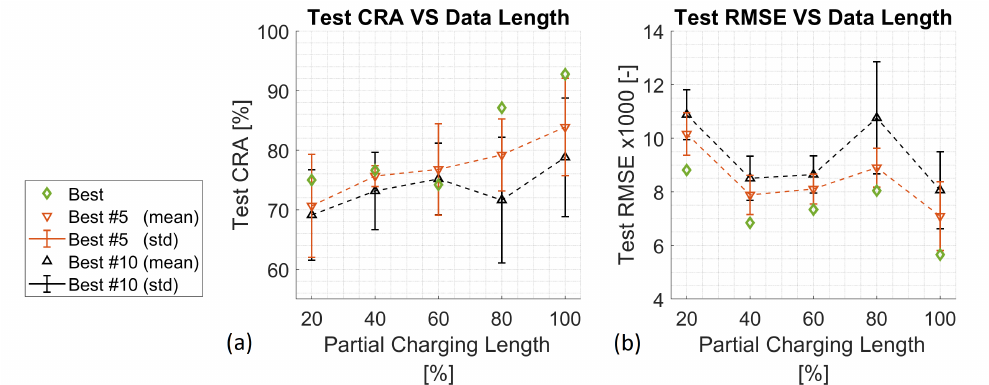
Figure 8. ( a ) CRA sensitivity analysis of the best one, five and 10 trained networks according to the RMSE on testing dataset. ( b ) RMSE sensitivity analysis of the best one, five and 10 trained neural networks according to the RMSE on testing dataset. For partial charging lengths, the minimum RMSE is equal to 0.0068 corresponding to 40% data length.